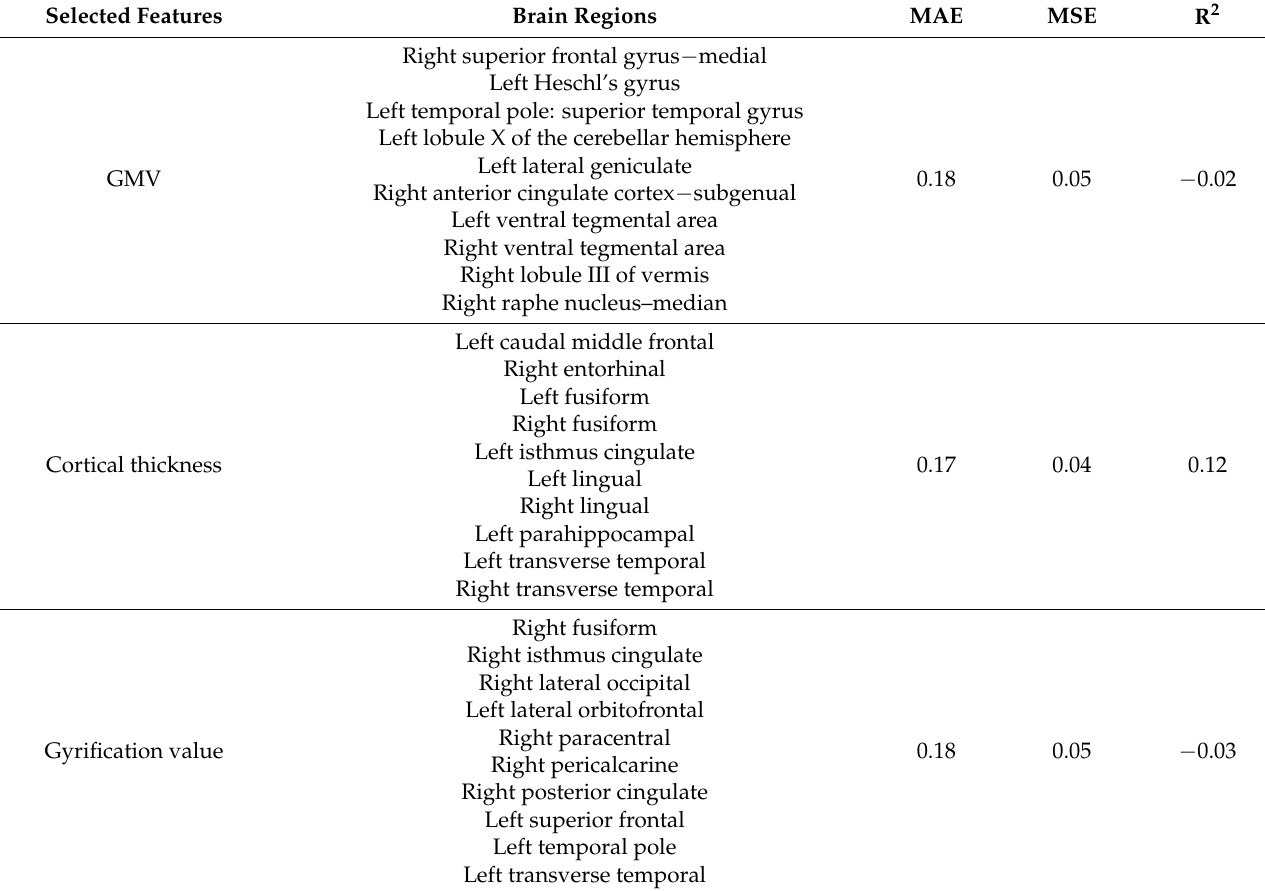
Table 3. Regression performance for different structural feature